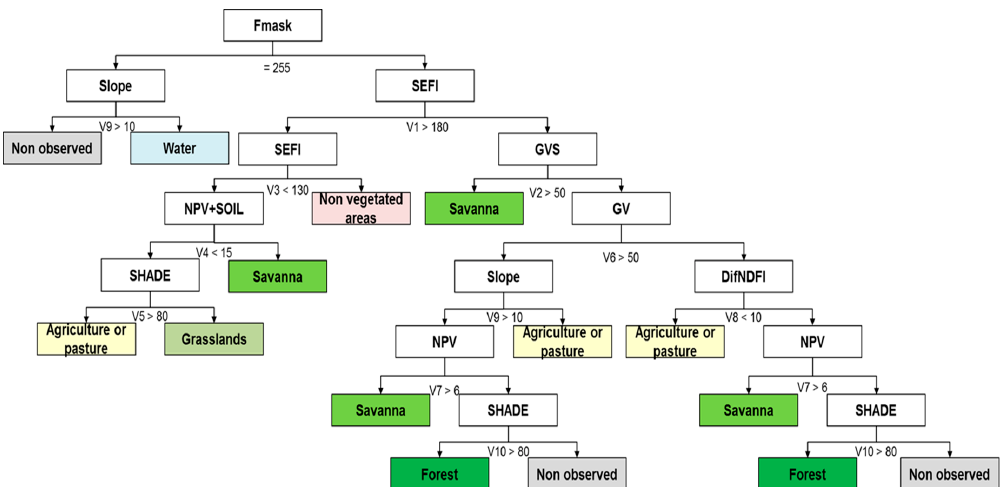
Figure 3. Empirical decision tree classification scheme based on the values of the spectral metrics in 262 known field inventory plots in the Cerrado biome, seeking to separate native vegetation classes (grassland, savanna, and forest) from land use-related classes (mostly agriculture and pastures) and other non-vegetated areas (e.g., urban areas, bare soils). Values below each split refer to the factors at each node above it.